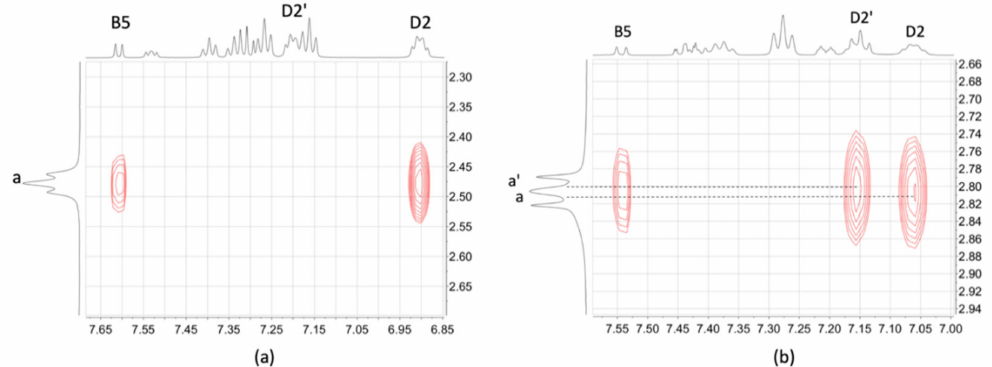
Figure 7. Part of the NOESY spectra (500 MHz, acetone-d 6 , 298 K) of ( a ) [Cu(xantphos)( 1 )][PF 6 ] showing NOESY crosspeaks between H a and H B5 , and H a and H D2 , and ( b ) [Cu(POP)( 1 )][PF 6 ] showing crosspeaks between the diastereotopic protons H a /H a’ and H B5 , between H a and H D2 , and between H a’ and H D2 (cid:48) .